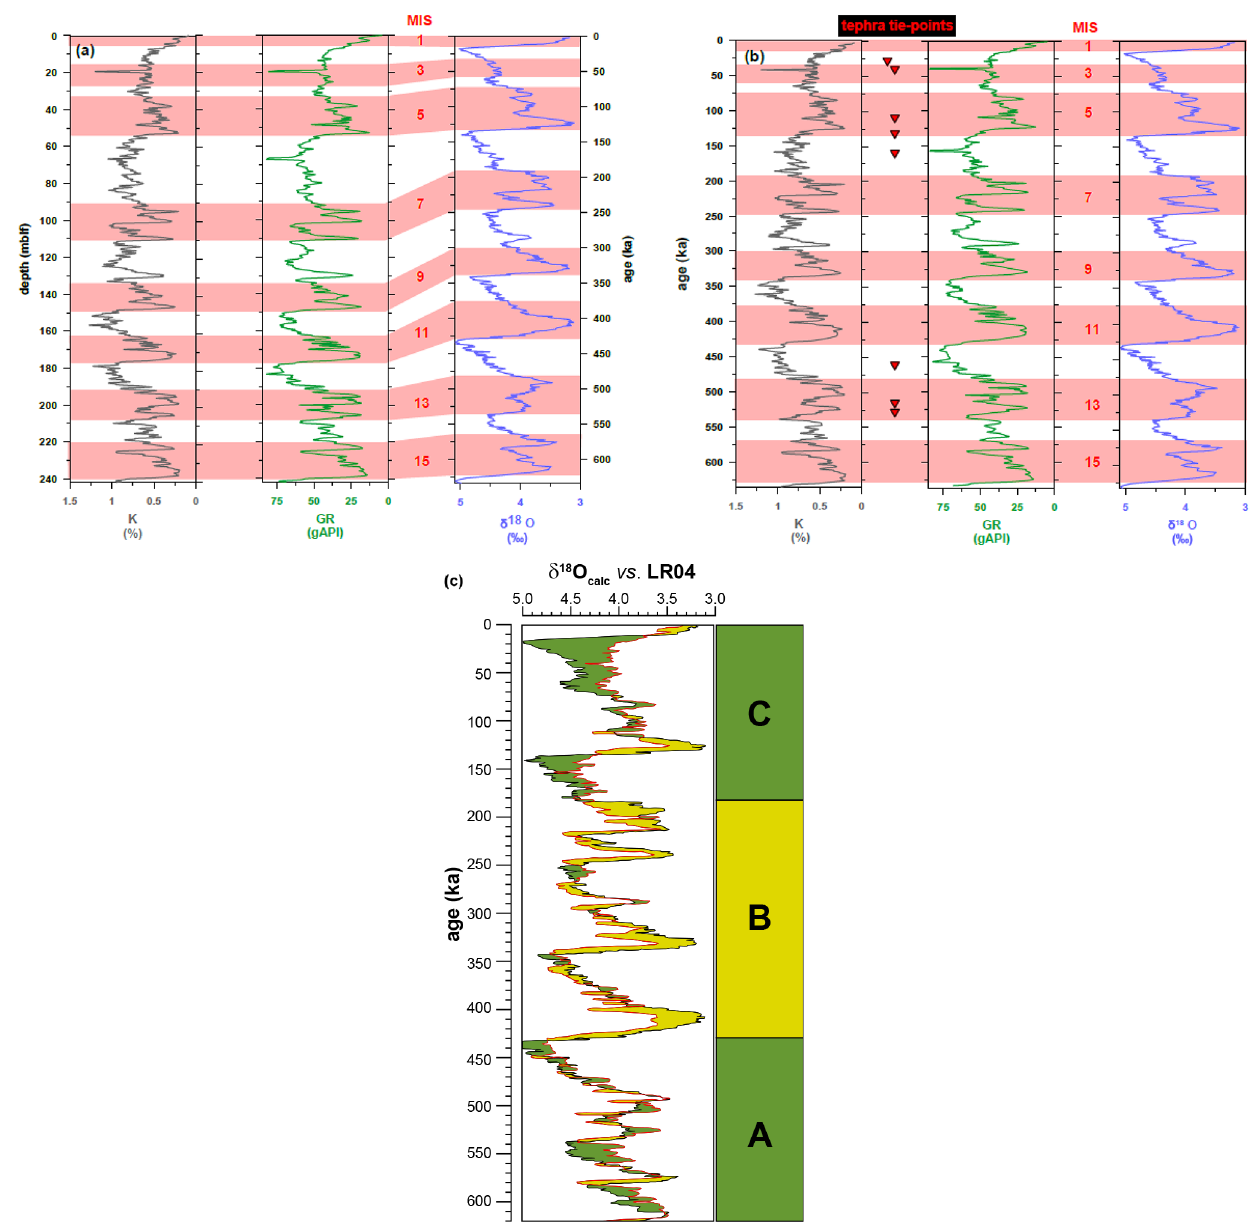
Figure 2. (a) Correlation of downhole GR and K data from 0 to 240mb.l.f. with LR04 (Lisiecki and Raymo, 2005) from 0 to 630ka. The age–depth range was set by eight anchor points from tephrochronology. Warm and/or humid periods correlate with periods of low GR and K values. (b) An age scale was applied to the downhole logging data (GR and K) based on tie points to LR04 (Lisiecki and Raymo, 2005) and from tephrochronology. (c) A synthetic curve calculated by linear regression between GR on timescale and LR04. Both curves are displayed as overlay and three zones are identified. A: 630 to 430ka (MIS 15 to 12); B: 430 to 185ka (MIS 11 to 7); C: 185 to 0ka (MIS 6 to 1). δ 18 O calc is prevailing decreased during zones A and C (dark-green colour) and higher in zone B (light-green colour) compared to LR04. K – potassium content from spectral gamma ray; GR – total gamma radiation; MIS – marine isotope stage; mb.l.f. – metres below lake